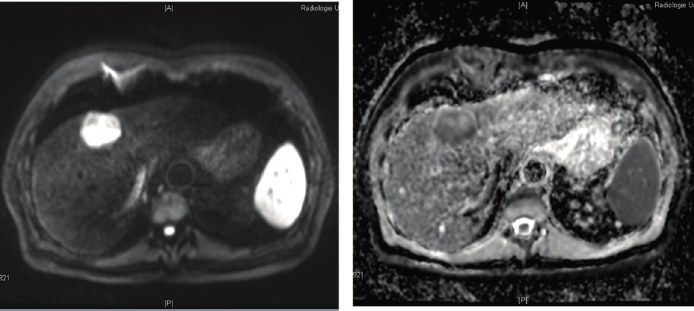
Figure 7. Diffusion-weighted imaging in a 67-year old patient with histology proven HCC. Liver lesion in the right hepatic lobe observed in a cirrhotic patient (same patient as in Figure 1). The HCC lesion is presenting with high signal in the diffusion-weighted image (left) with high b -value ( b = 800 s/mm 2 ) and shows reduced ADC when compared to the surrounding liver parenchyma